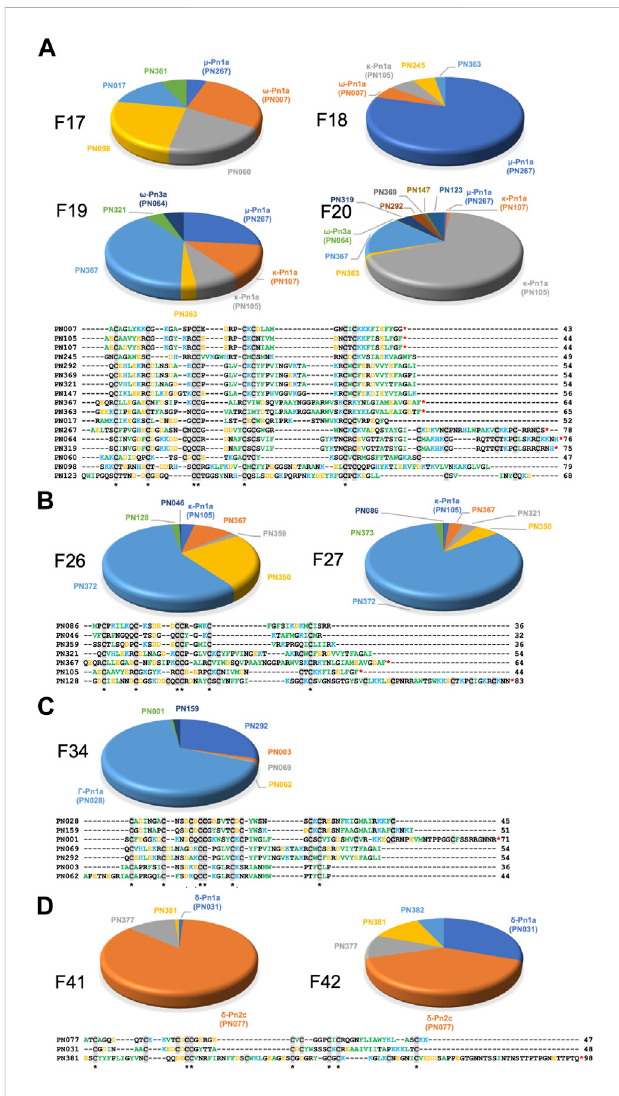
from the venom of P. nigriventer . (A) Identi fi cation of the cysteine-rich peptides and proteins in fractions 17 – 20 displaying potent inhibition of neuronal Na V and Ca V 2 channels. Positivelyand negativelycharged residues are coloured blue and orange, respectively, hydrophobic residues are green, and cysteines are highlighted in grey box. (B) Identi fi cation of the peptide and protein content of the fractions 16 and 27displayingpotent inhibition ofneuronal Na V , Ca V 1and Ca V 2channels. (C) Identi fi cation of the peptide and protein content of the fraction 34displayingpotentinhibitionofneuronalNa V ,Ca V 1andCa V 2channels. (D) Identi fi cation of the peptide and protein content of the fraction 34 displaying potent activation of neuronal Na V and Ca V 2 channels. Sequences labelled with a red asterisk (*) at the C-terminal are likely C-terminally